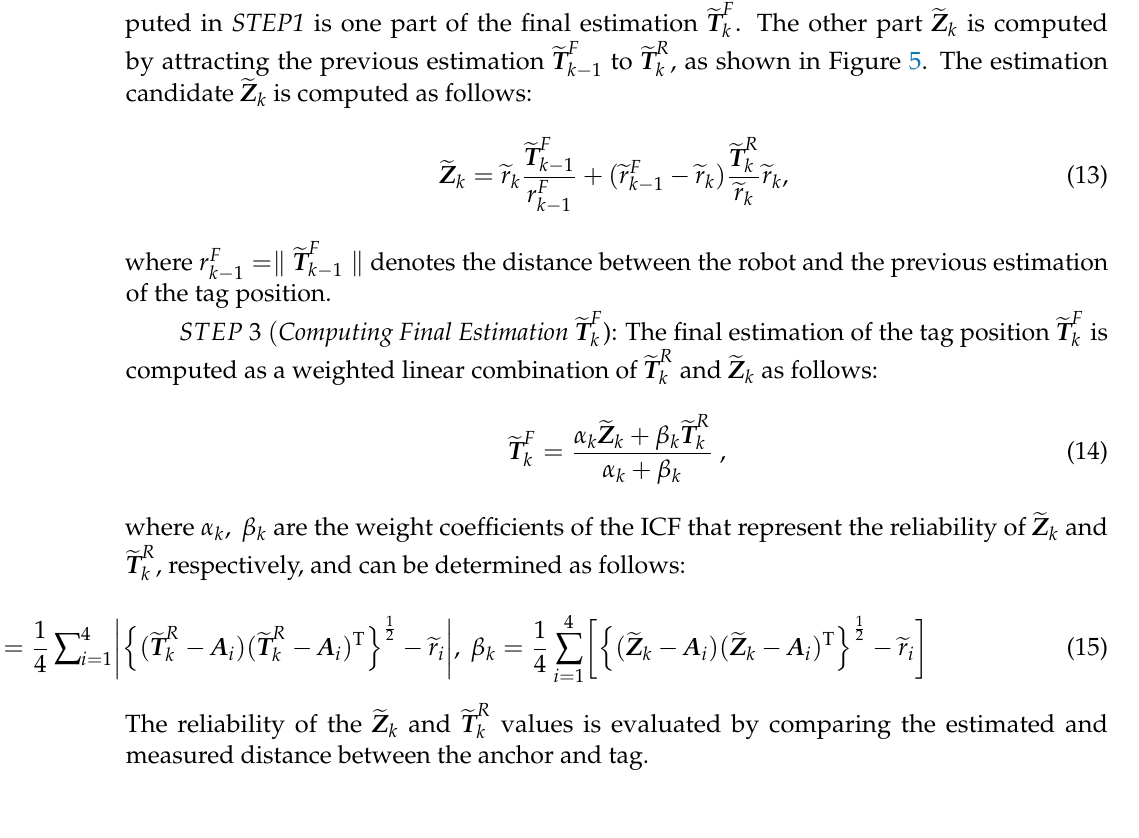
Figure 5. Computing estimation candidate 𝒁 ̃ 𝑘 from previous estimation 𝑻 ̃ 𝑘−1 𝐹 .